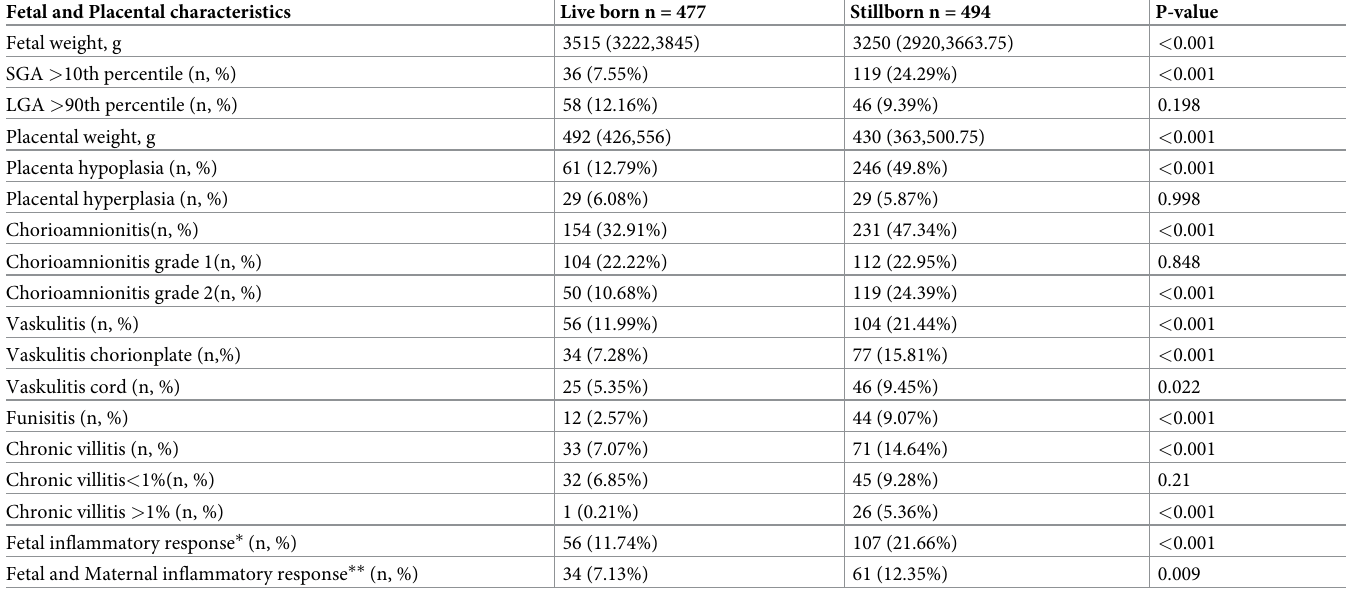
Table 2. Placental inflammatory lesions from term pregnancies with live born infants and stillborn infants. For continuous variables medians with interquartile range are expressed and for categorical variables numbers and proportions are